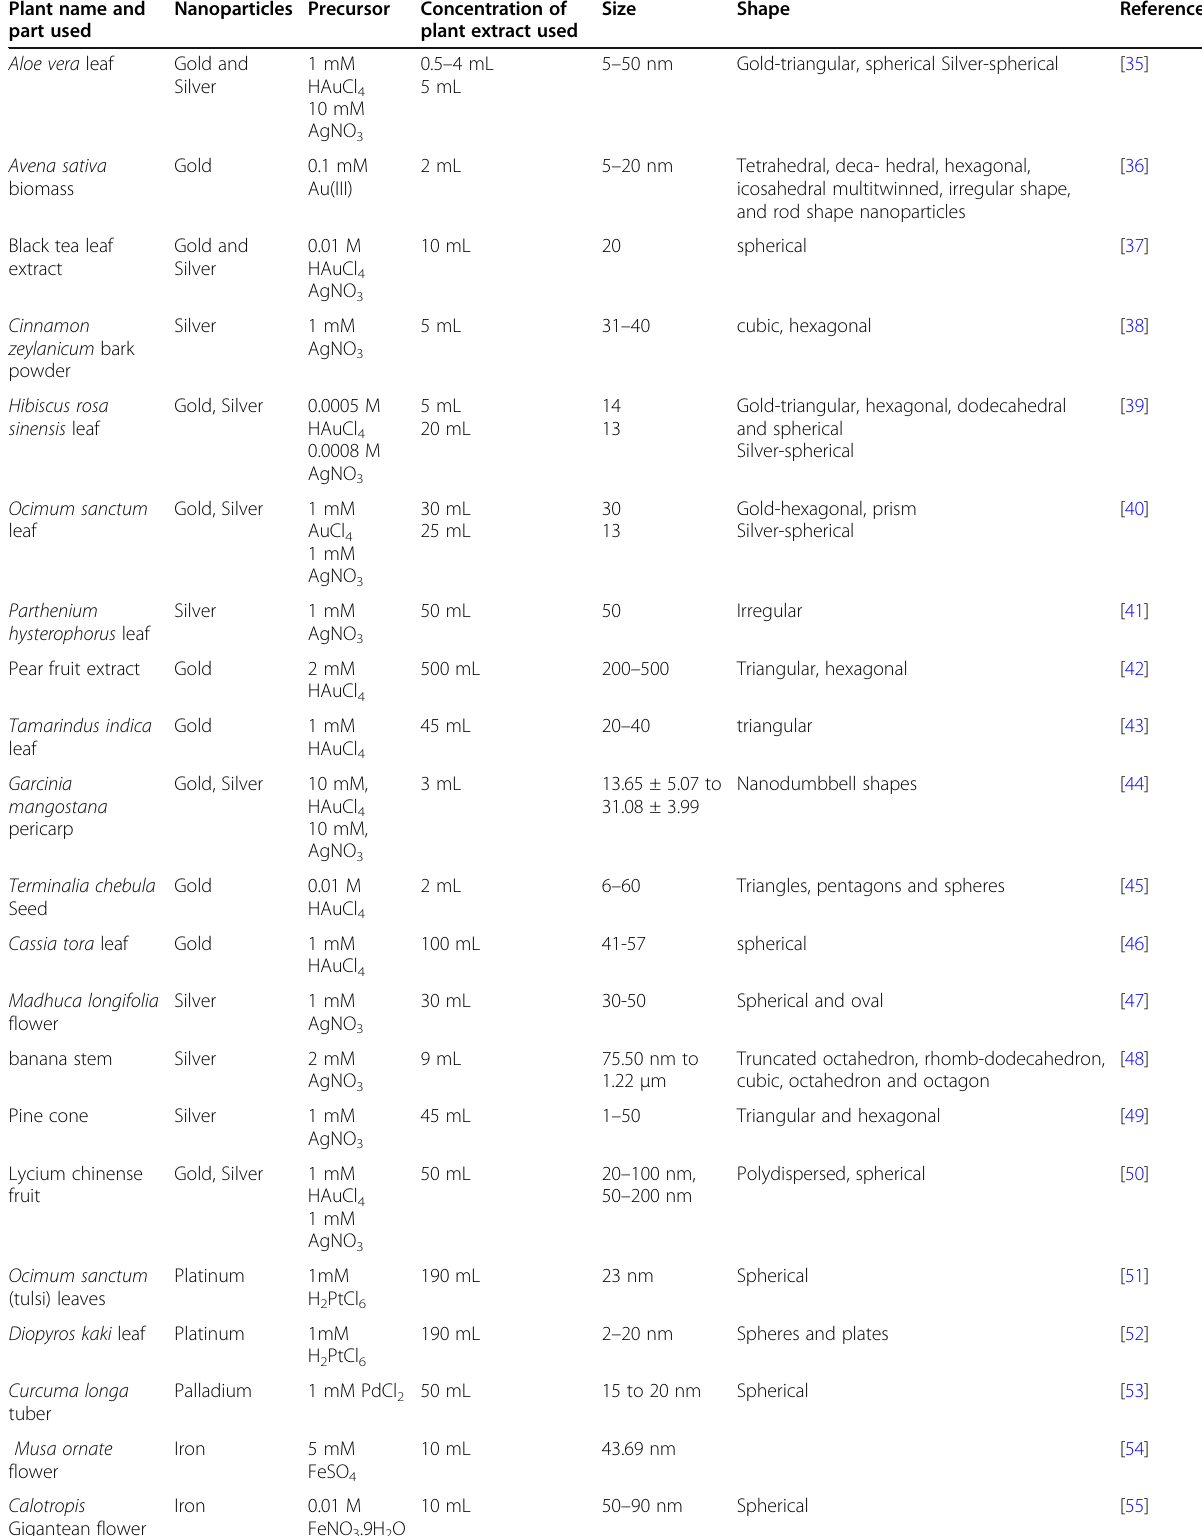
Table 1 Effect of biological material, precursor concentration and extract concentration on the morphology of biological